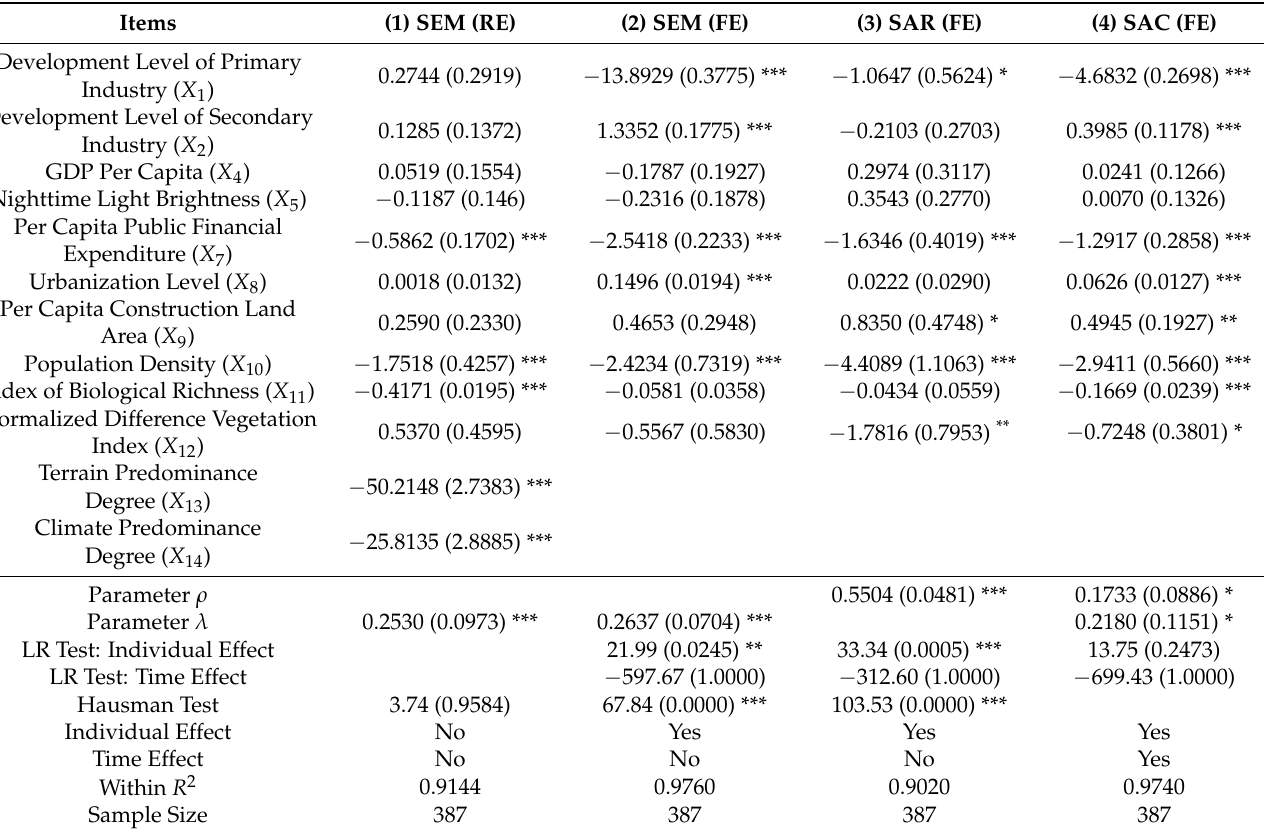
Table 7. Regression Results of Influencing Factors of Rural